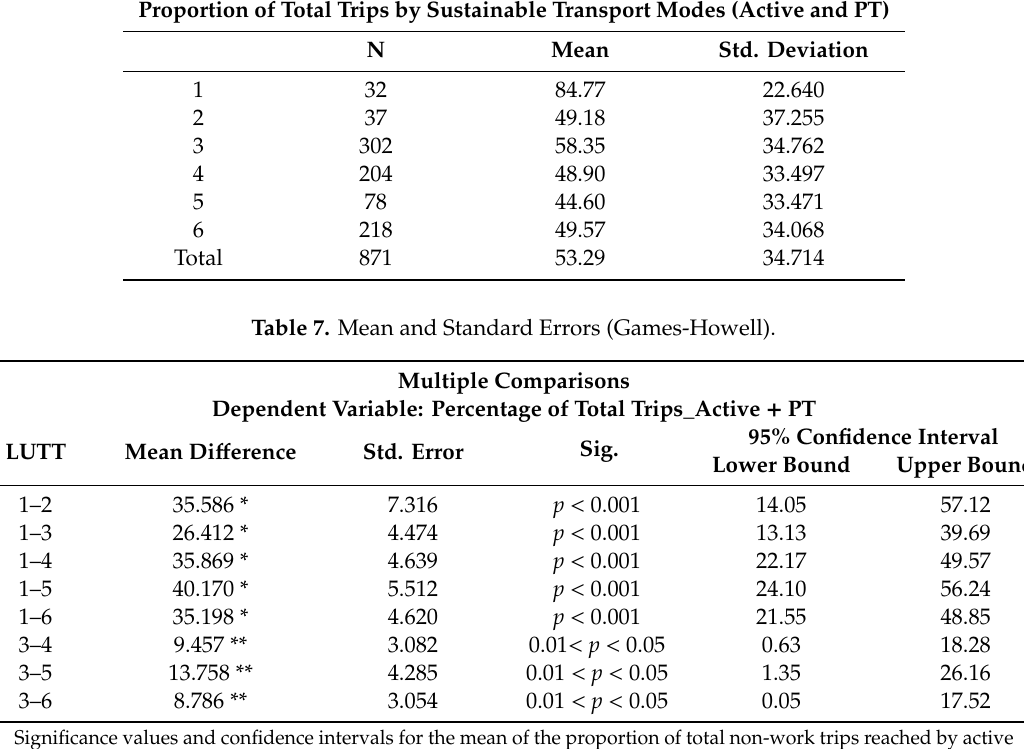
Table 6. Mean and Ns for the LUTTS included in the Welch’s ANOVA analysis.